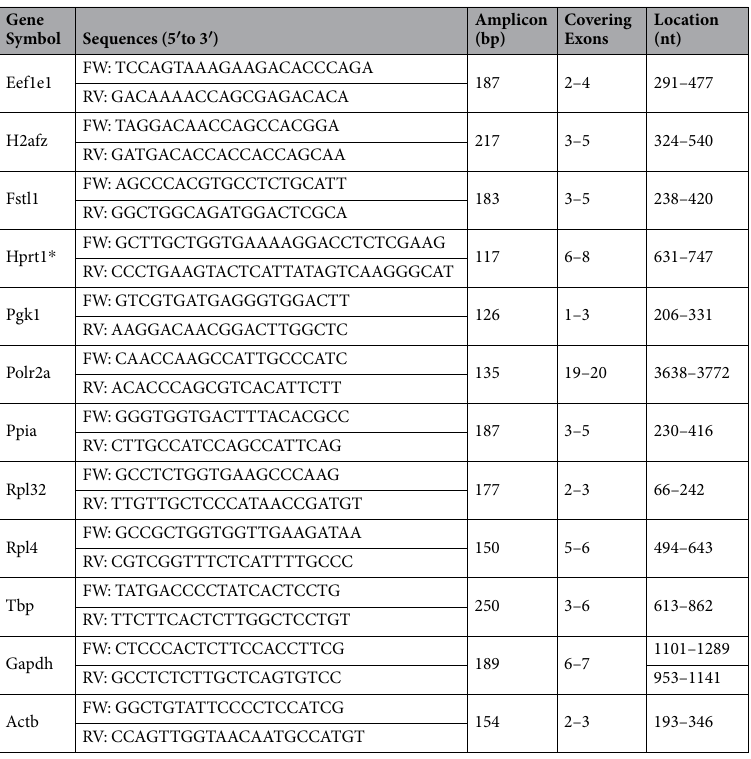
Table 3. PCR primers and amplicon information. * Sequences obtained from ref.